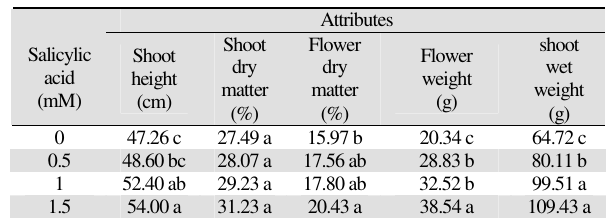
Tab. 1. Effect of different salicylic acid concentrations